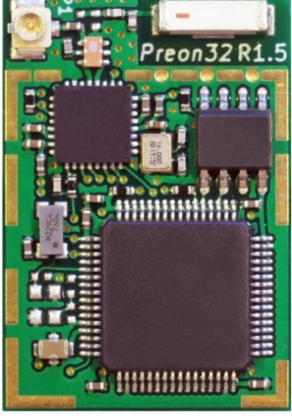
Figure 10. Preon32 sensor